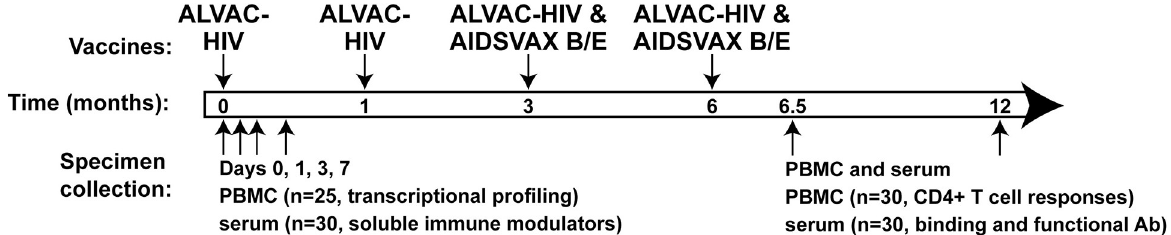
Fig 1. Specimen collection for immune response evaluation in the active groups in the HVTN 097 trial. South African study participants received ALVAC-HIV at Months 0 and 1 followed by ALVAC-HIV and AIDSVAX B/E at Months 3 and 6. PBMC and serum/plasma were collected pre-vaccination and at Days 1, 3 and 7 after the first ALVAC-HIV vaccination for evaluation of innate immune responses and at 2 weeks and 6 months after the fourth vaccination for evaluation of adaptive immune responses.